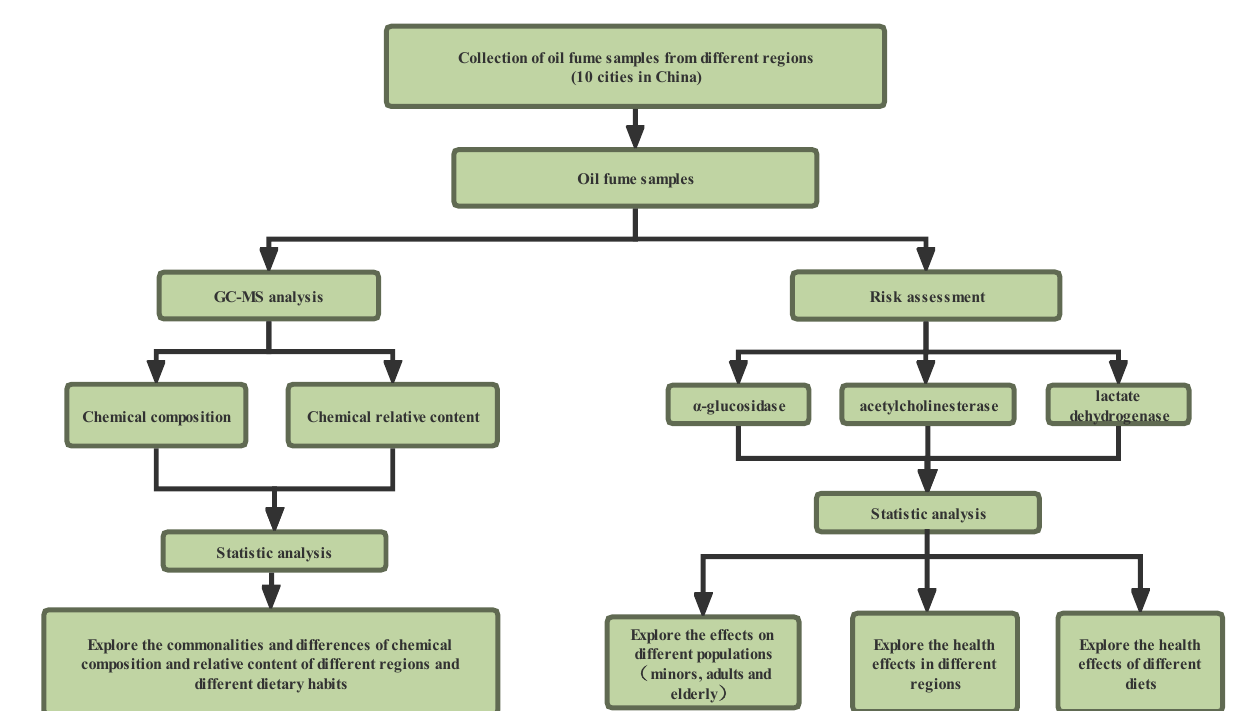
Figure 1. The design flowchart of this study.